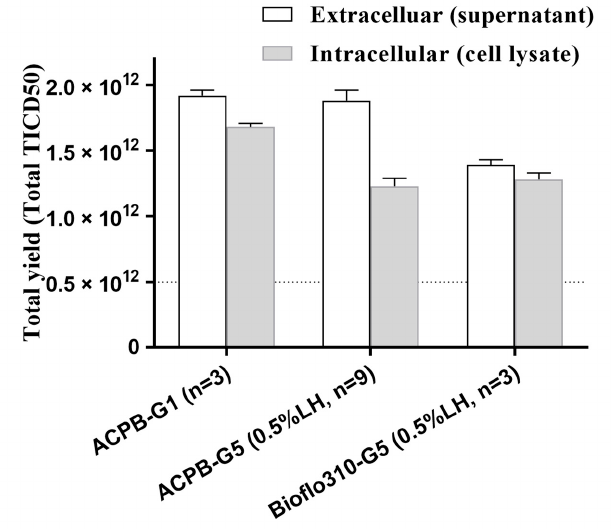
Figure 4. Total yield of virus in the cell lysates (intracellular) and supernatants (extracellular) from the ACPB and Bioflo310 systems using the G1 and G5 strategies. NBS-Bioflo310, New Brunswick